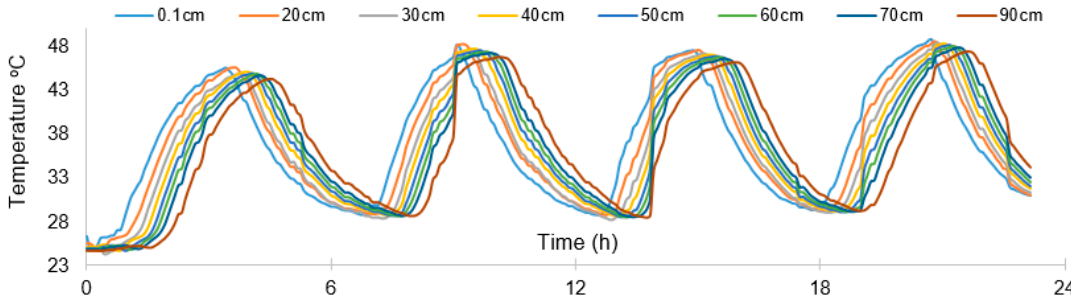
Figure 4. Raw temperature time series from eight sensors installed at different depths and sampled every 5 min.